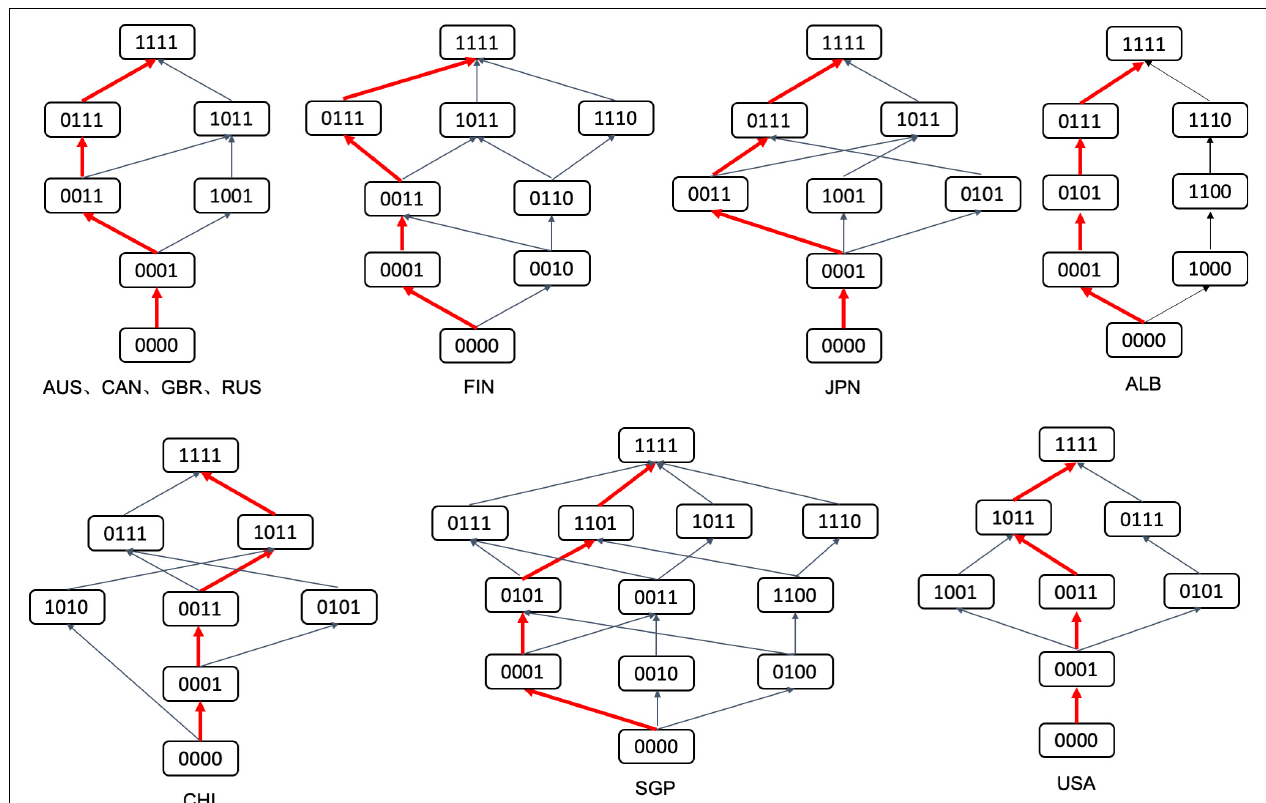
FIGURE 4 | Students’ learning trajectories in 10